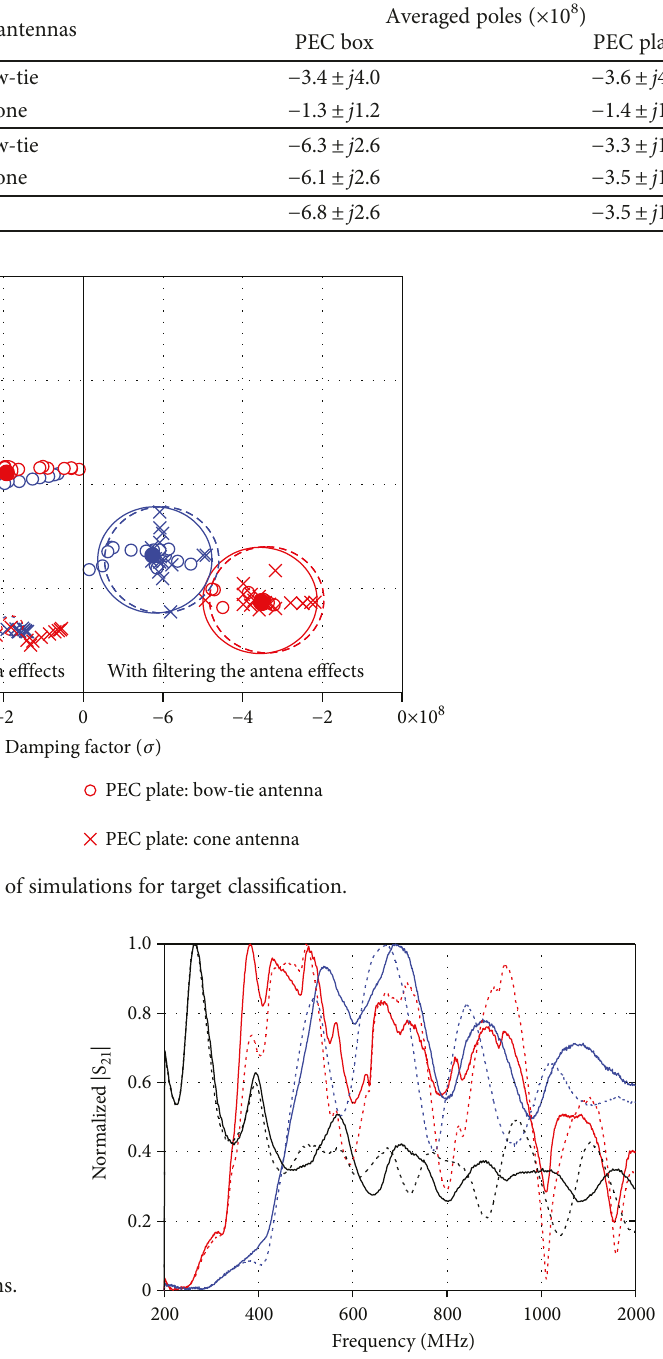
Table 1: Summary of the extracted poles in the late time of simulation results.